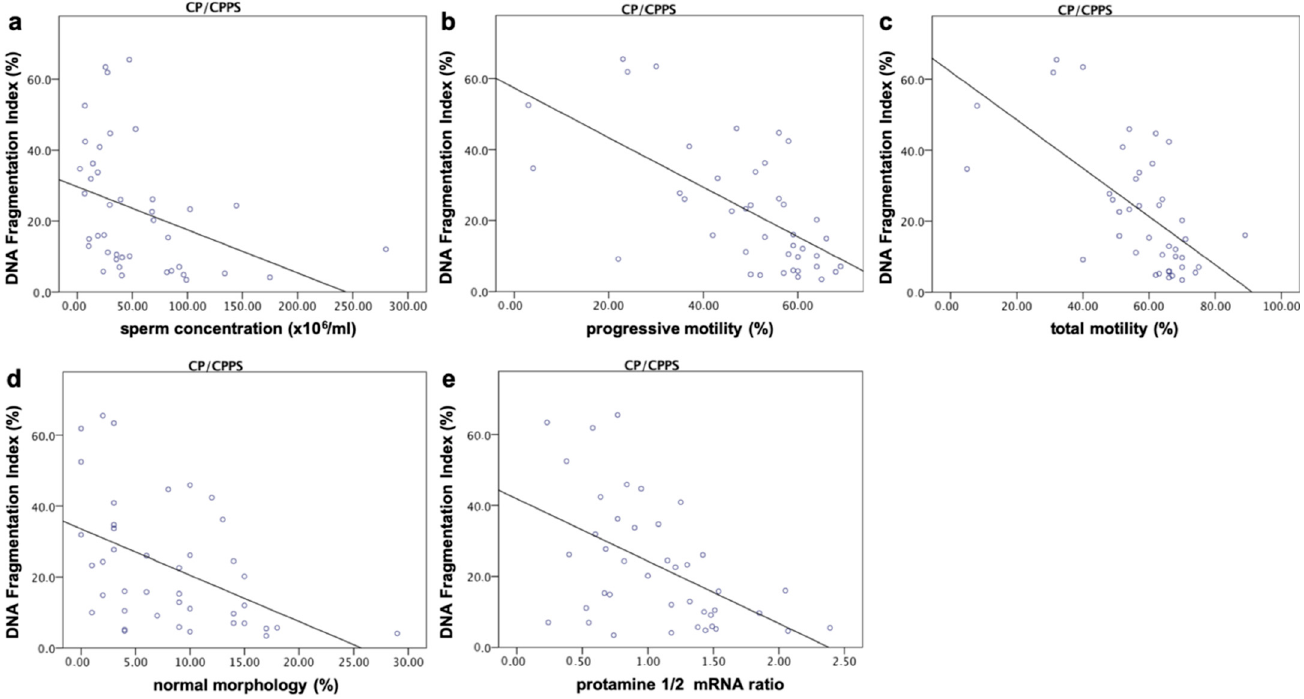
Figure 2. Correlations between DFI and sperm parameters. The DFI showed significant negative correlations with total sperm number (r = − 0.320, p ≤ 0.05, not shown), sperm concentration (r = − 0.508) ( a ), progressive (r = − 0.636) and total motility (r = − 0.625) ( b , c ), normal morphology (r = − 0.511) ( d ) as well as the protamine 1/2 mRNA ratio ((r = − 0.494) ( e ); for all parameters p ≤ 0.001). The DFI was significantly positively associated with sperm head (r = 0.345, p ≤ 0.05, not shown) and tail defects (r = 0.621, p ≤ 0.001, not